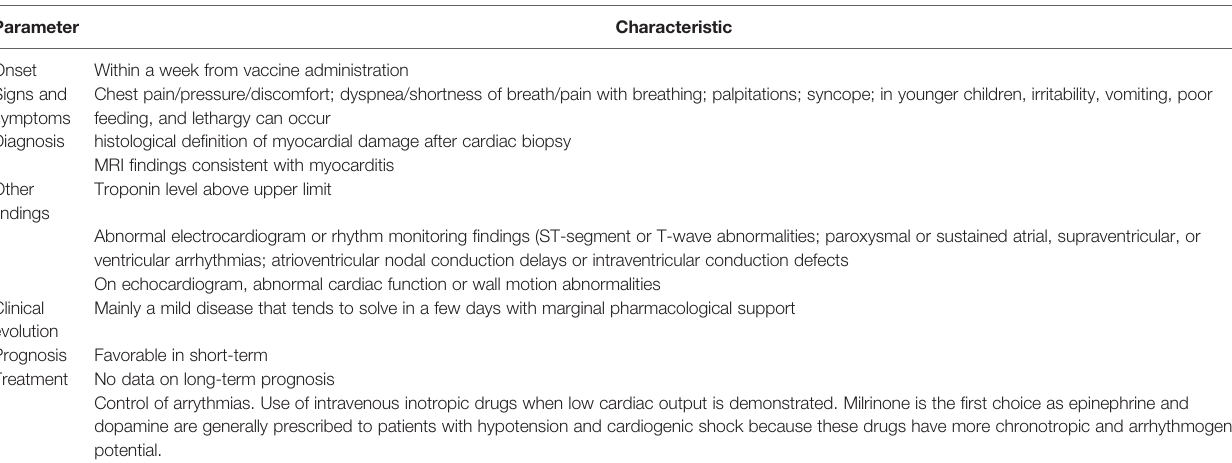
TABLE 2 | Main characteristics of myocarditis associated with COVID-19 mRNA vaccines. Parameter